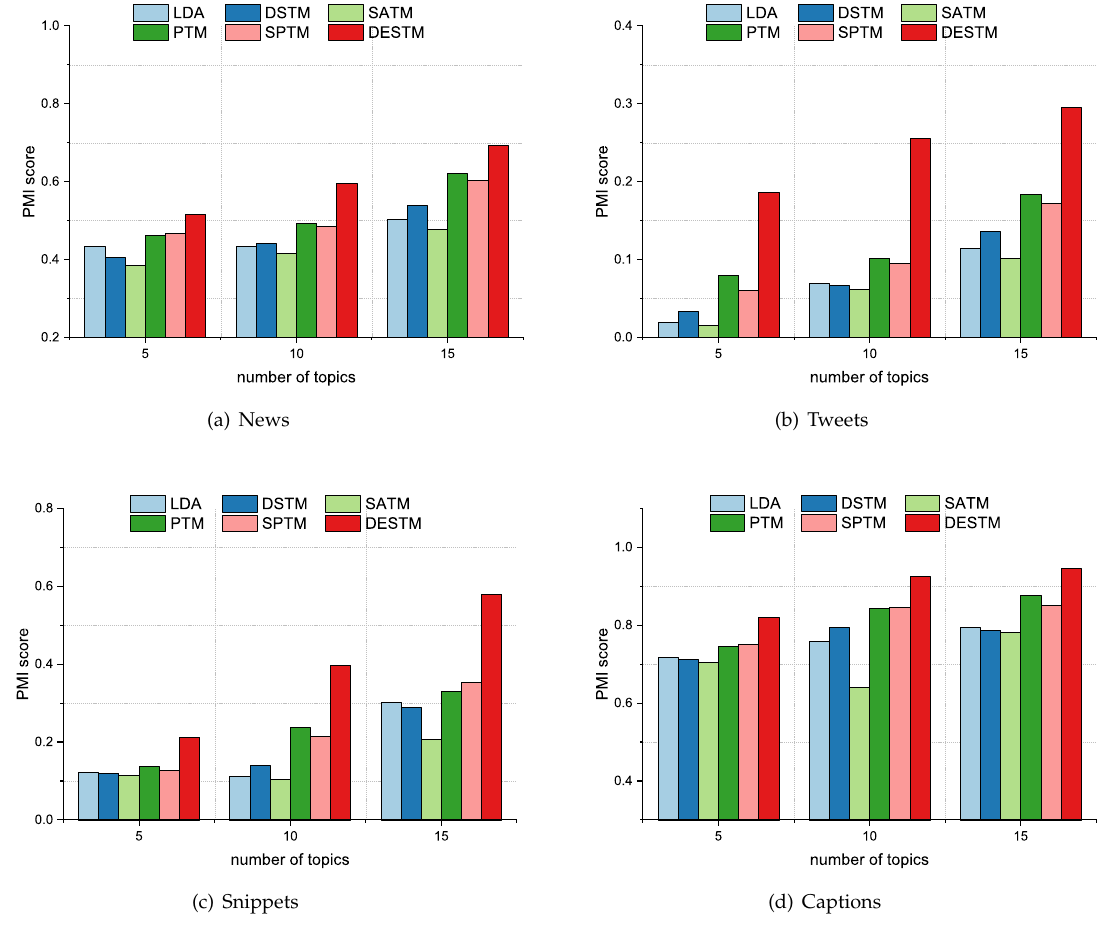
Figure 2. Average PMI score of all models on 4